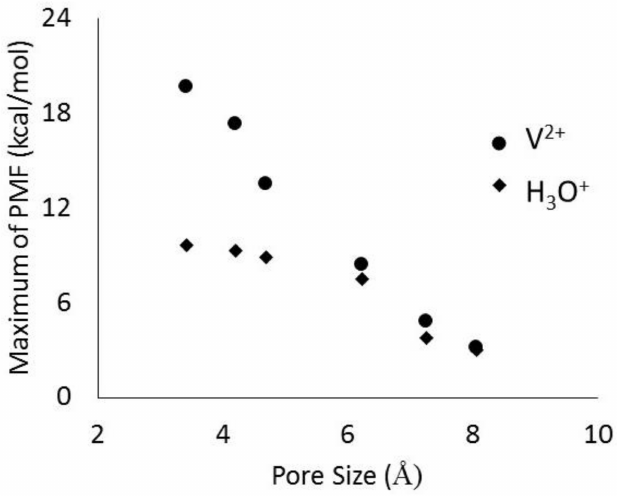
Figure 10. Magnitude of free energy barriers for V 2+ and H 3 O + ions as they traverse the pore of different zeolite membranes.